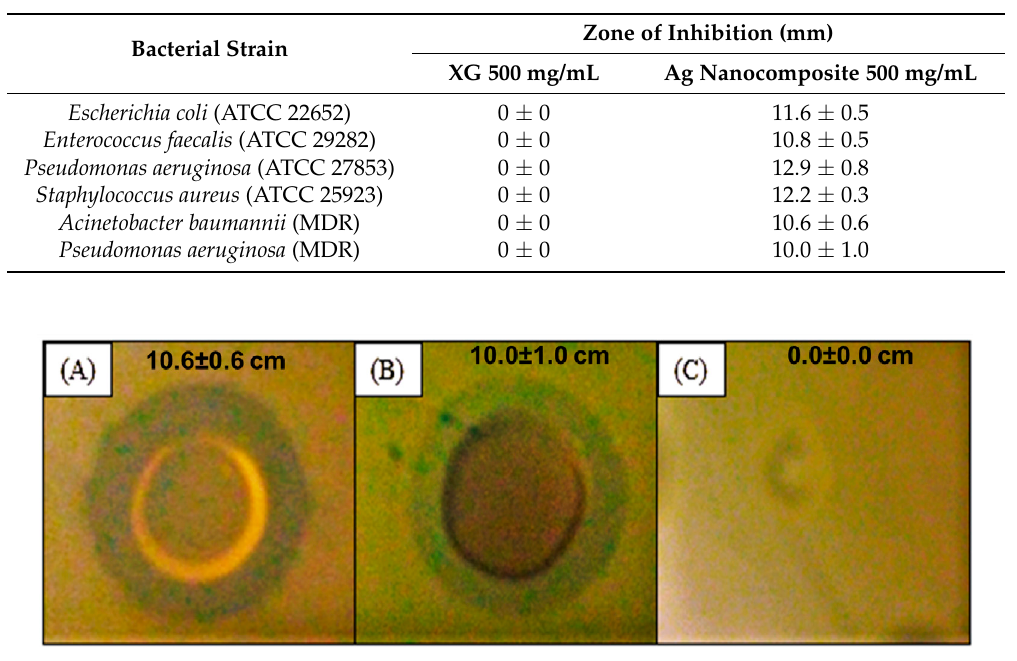
Figure 2. Inhibition zone pictures of silver nanocomposite against A. baumannii ( A ) and multi-resistant P. aeruginosa ( B ); Xanthan gum without silver nanoparticles was also tested against the cited bacteria ( C ).